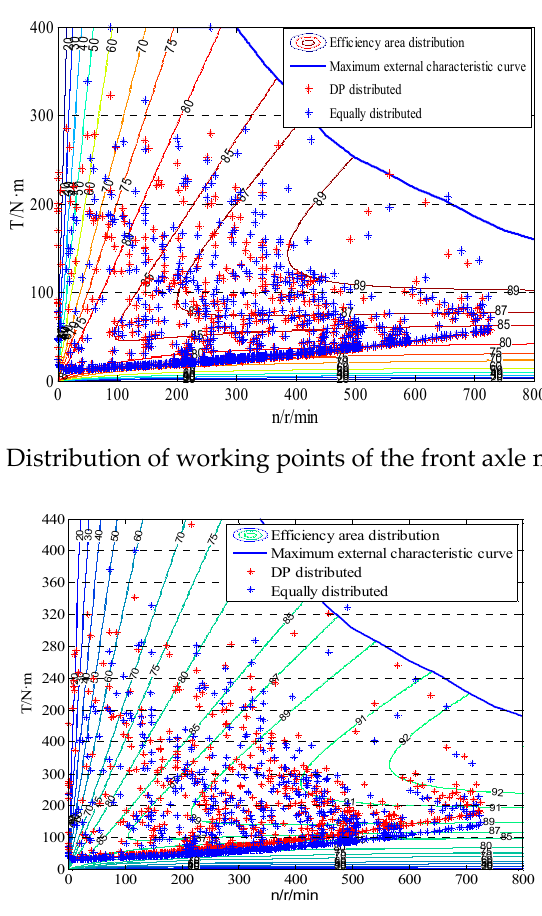
Figure 10. Distribution of motor operating points in different torque distribution strategies for CUPDC.